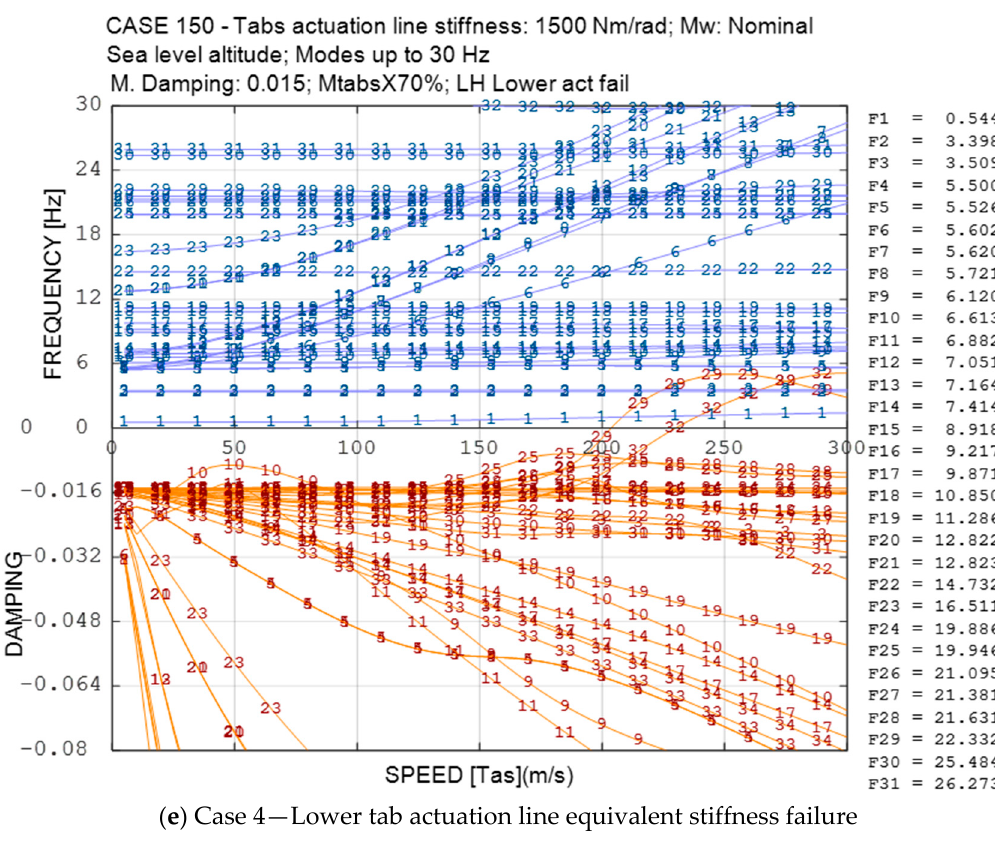
Figure 13. Failure cases of the morphing winglet.